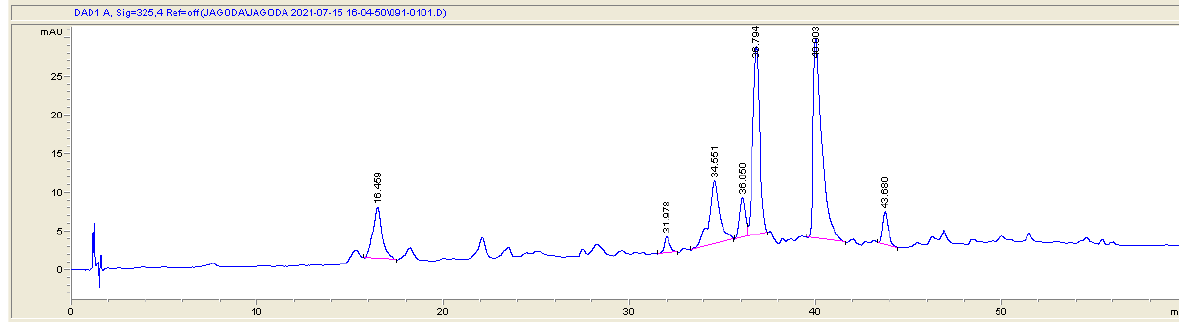
Figure 3. The chromatogram of the quantitative UHPLC analysis of V. amygdalina methanolic